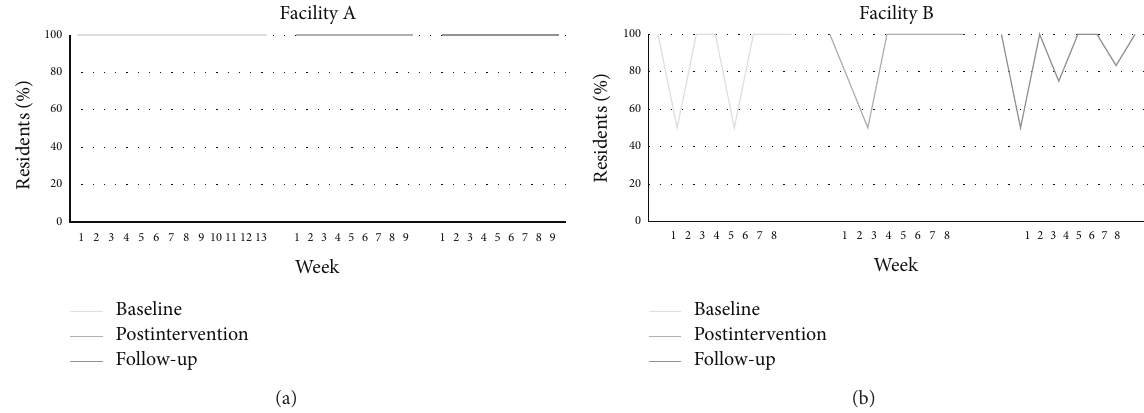
Figure 4: Percentage of residents assessed with standardized tool who had moderate-to-severe pain reassessed for pain within 24 hours. Note . For Facility A, the percentages are based on a number of residents ranging from 𝑁 = 4–48 (the denominator varied from week to week). For Facility B, the percentages are based on a number of residents ranging from 𝑁 = 1–7 (the denominator varied from week to